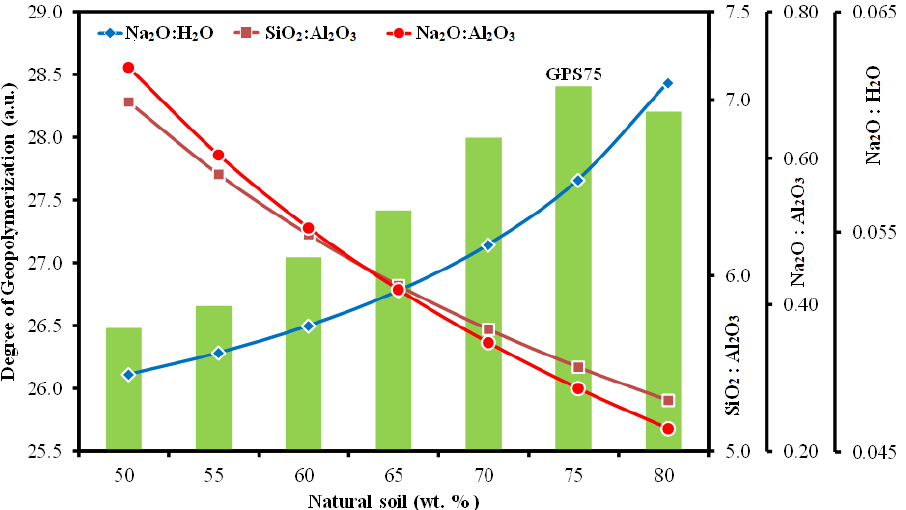
Figure 5. Degree of GPN vs. molar ratios of SiO 2 :Al 2 O 3 , Na 2 O:Al 2 O 3 , and Na 2 O:H 2 O as a function of NS wt. fractions.